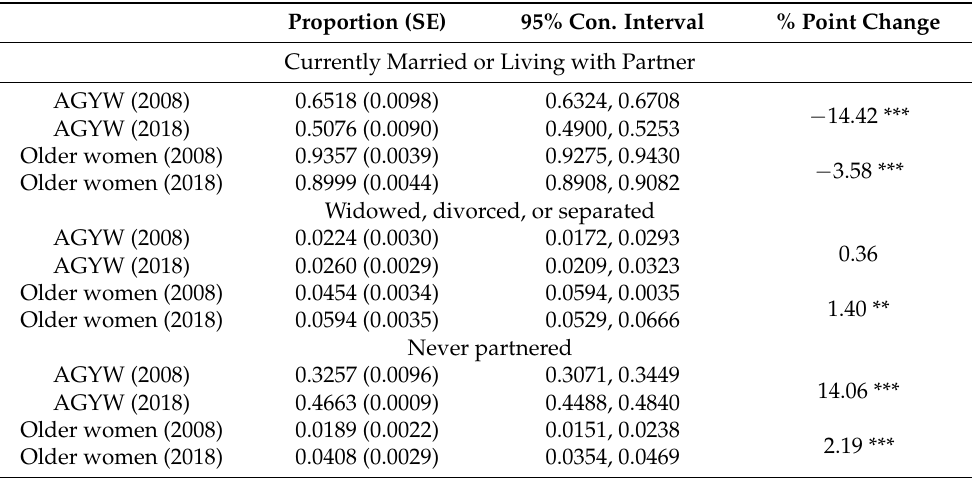
Table 4. Changes in the proportion of all female respondents in Northeast Nigeria, split by age group and year, in